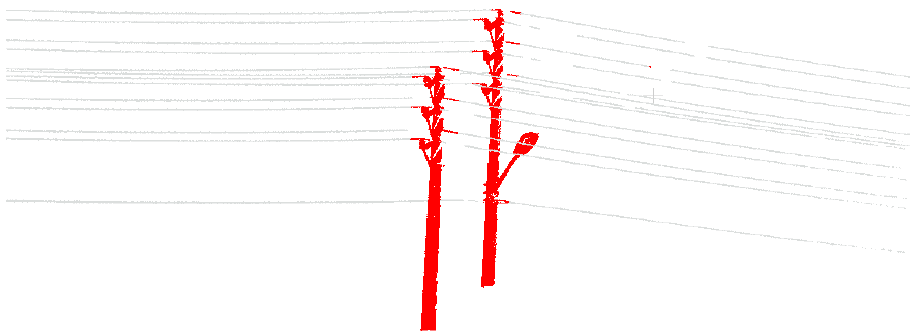
Figure 13. The missing powerlines points close to the pylons.